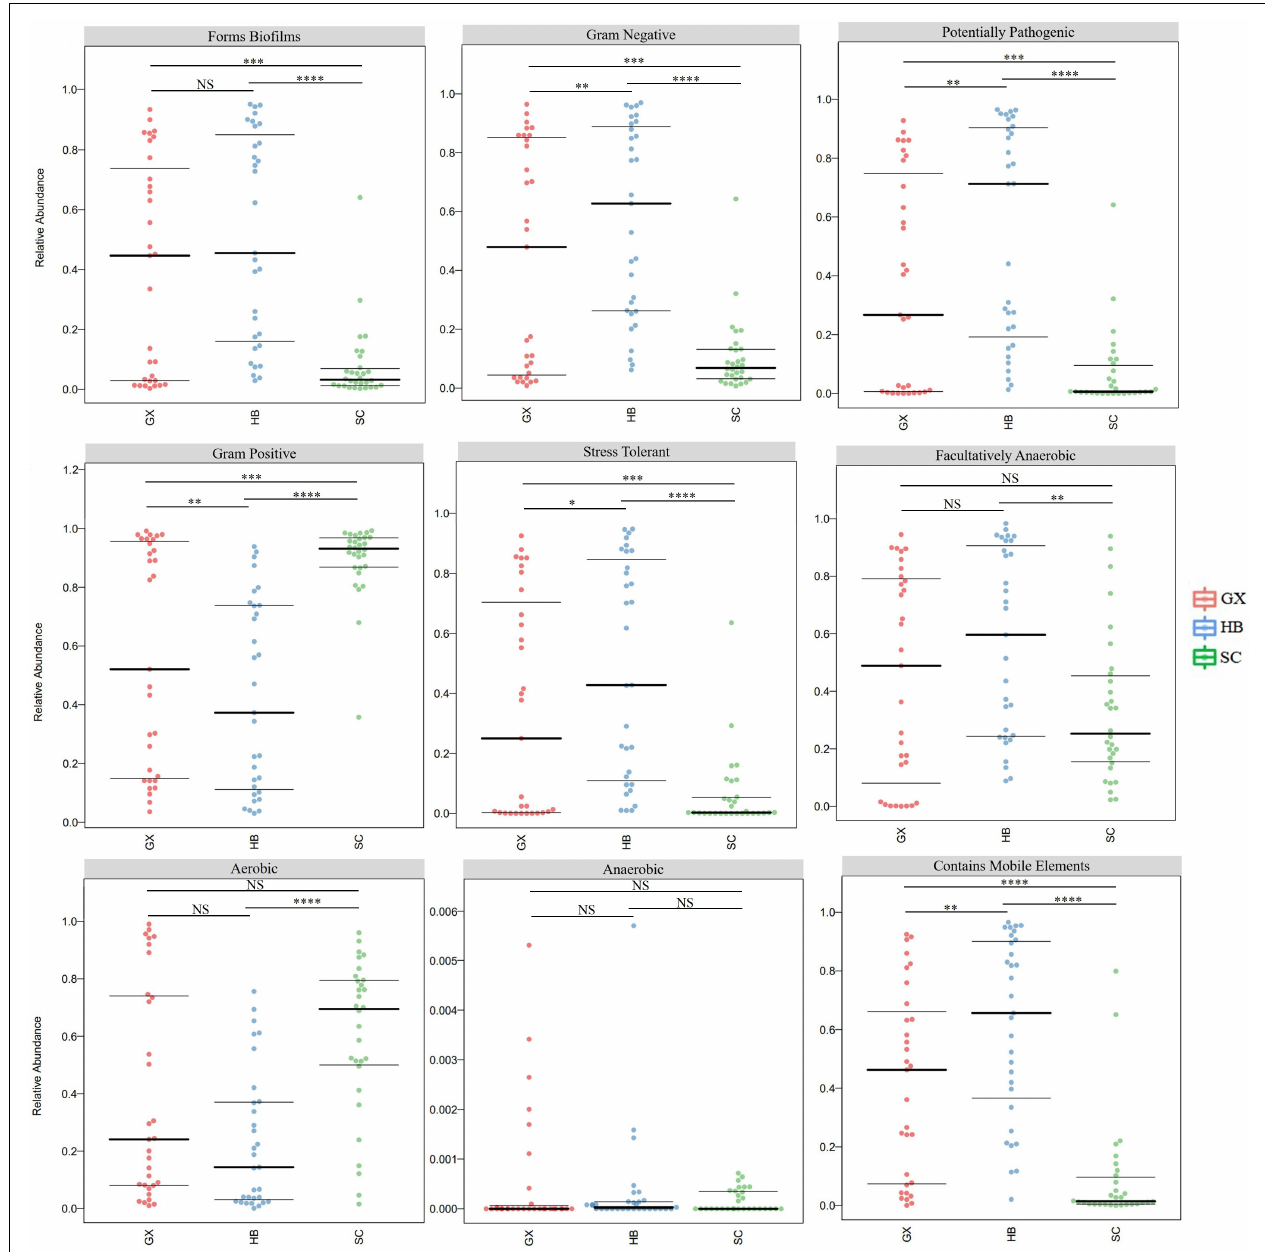
FIGURE 5 | Comparative analysis of bacterial phenotypic results of rice wine koji samples. Significant differences are represented by ****( p < 0.0001), ***(0.0001 ≤ p < 0.001), **(0.001 ≤ p < 0.01), *(0.01 ≤ p < 0.05), and ns ( p ≥ 0.05). HB, GX, and SC represent Hubei City, Guangxi Province, and Sichuan Province,